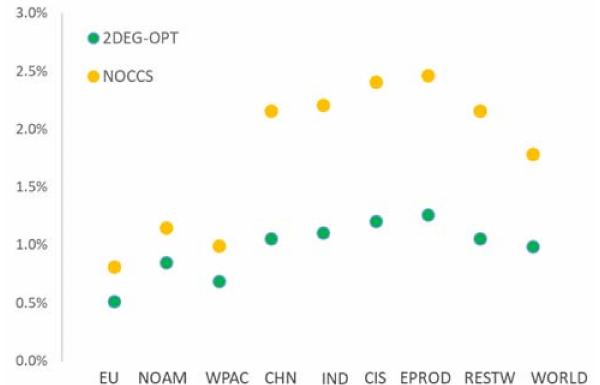
Figure 11. Additional energy system costs by region in decarbonization scenarios relative to reference (as % of GDP over